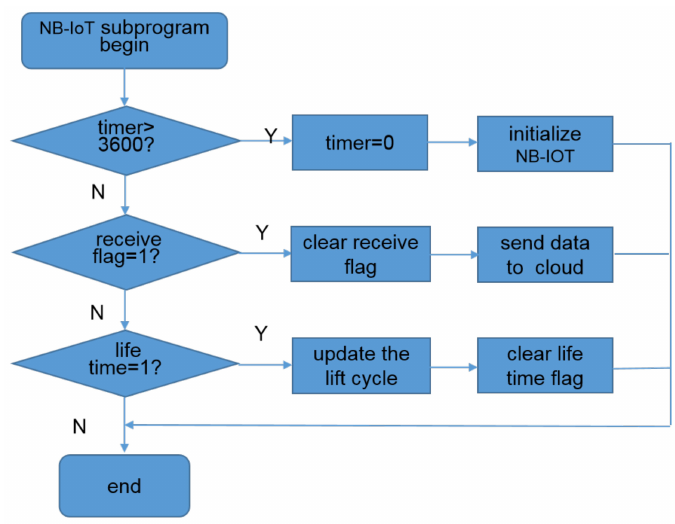
Figure 5. The Flowchart of NB-IoT